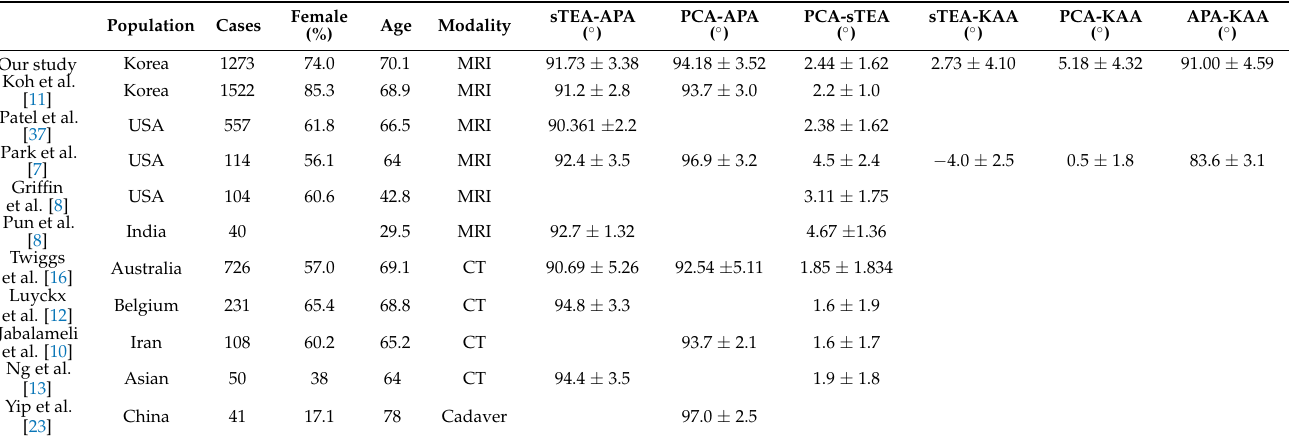
Table 4. Comparison of angles between axial references with those in previous studies.